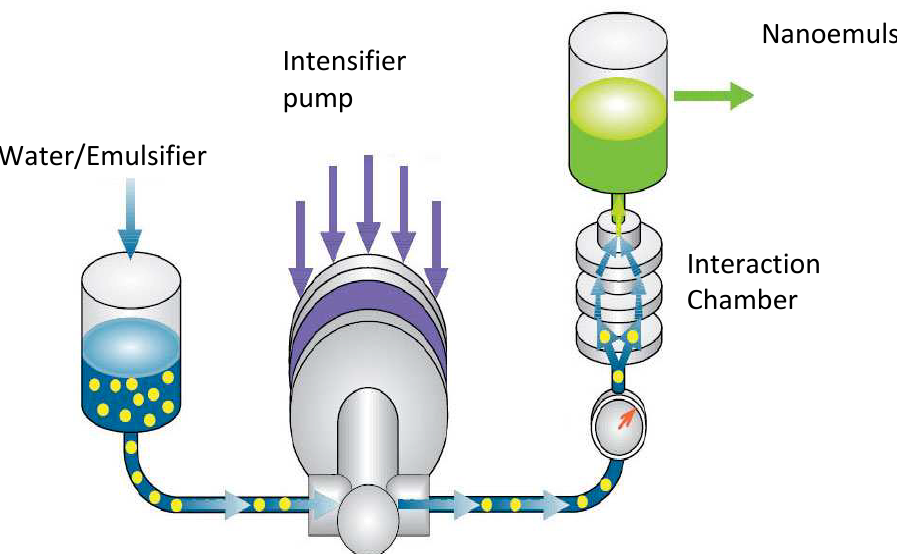
Figure 2. Microfluidizer TM processor used for top-down